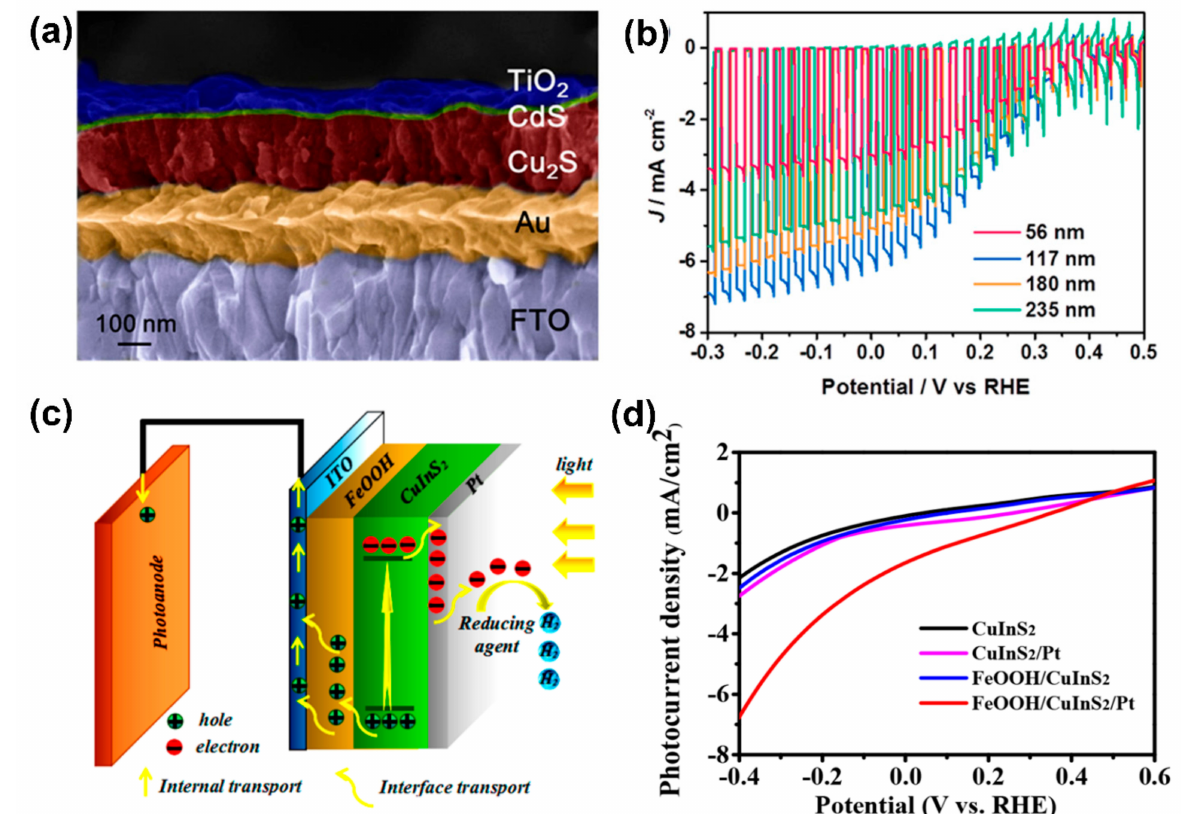
Figure 7. ( a ) Cross-sectional SEM of the different layer having FTO/Au/Cu 2 S/CdS/TiO 2 ; ( b ) J– V curves of different thickness of the Cu 2 S layer in the FTO/Au/Cu 2 S/CdS/TiO 2 photocathode. Produced with the permission of ref. [89]. Copyright 2018, American Chemical Society. ( c ) Schematic illustration of the FeOOH/CuInS 2 /Pt photocathode with an electron transfer mechanism; ( d ) J–V curves of the CuInS 2 , CuInS 2 /Pt, FeOOH/CuInS 2 , FeOOH/CuInS 2 /Pt photocathode. Produced with the permission of ref. [90]. Copyright 2018, American Chemical